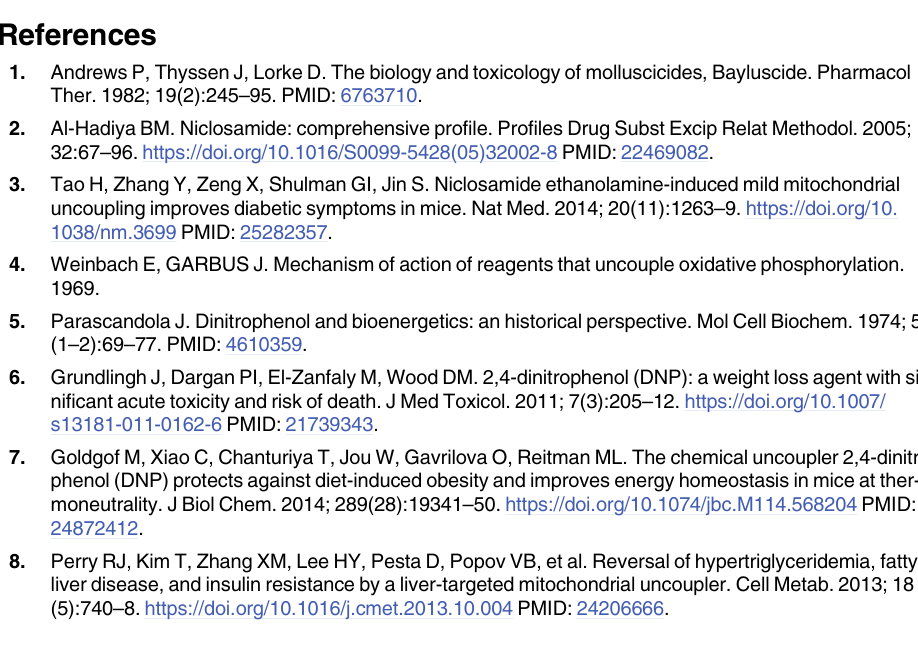
S1 Table. SAR for N-substituted phenylbenzamides. S1 Fig.